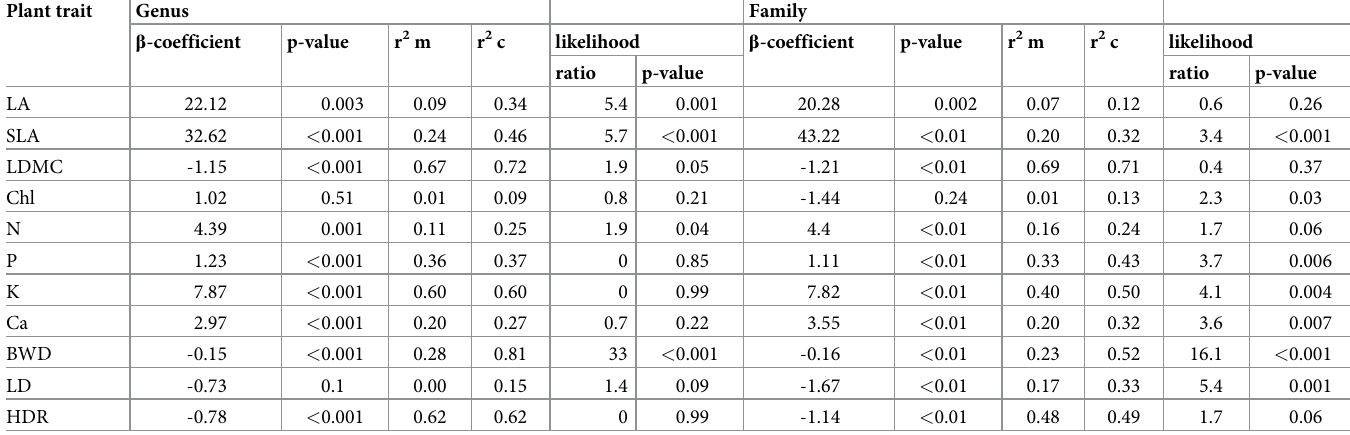
Table 5. Variation in 11 functional traits of white- and black-water flooded forests considering pairing at genus and family level. The columns indicate β -coefficient, p-value, marginal R squared (variance explained by the fixed effect (habitat); r 2 m), conditional R squared (variance explained by the fixed effect + random effect (habitat + genus/family); r 2 c) and likelihood ratio test (p-value indicates if models differ; ratio was calculated as model 1 (habitat + genus/family)/model 2